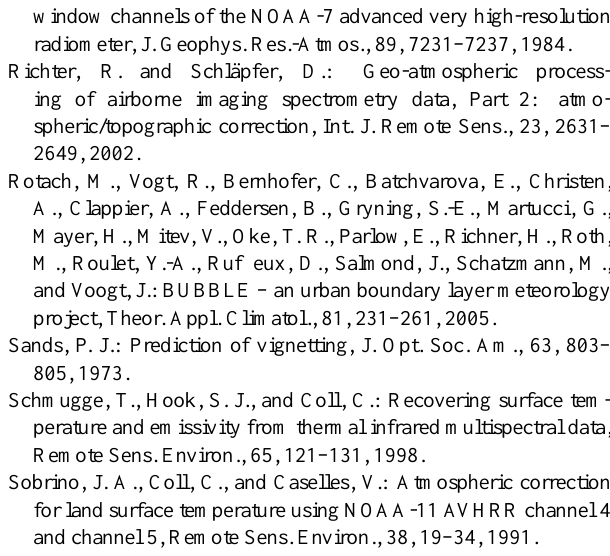
Price, J. C.: Land surface temperature measurements from the